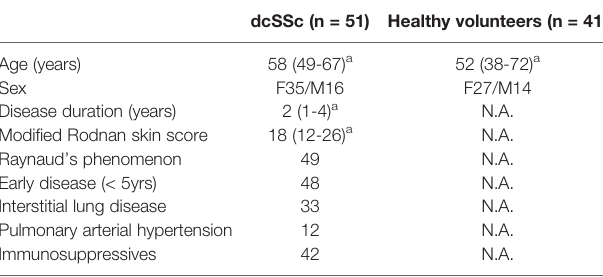
TABLE 1 | SSc patients and healthy controls